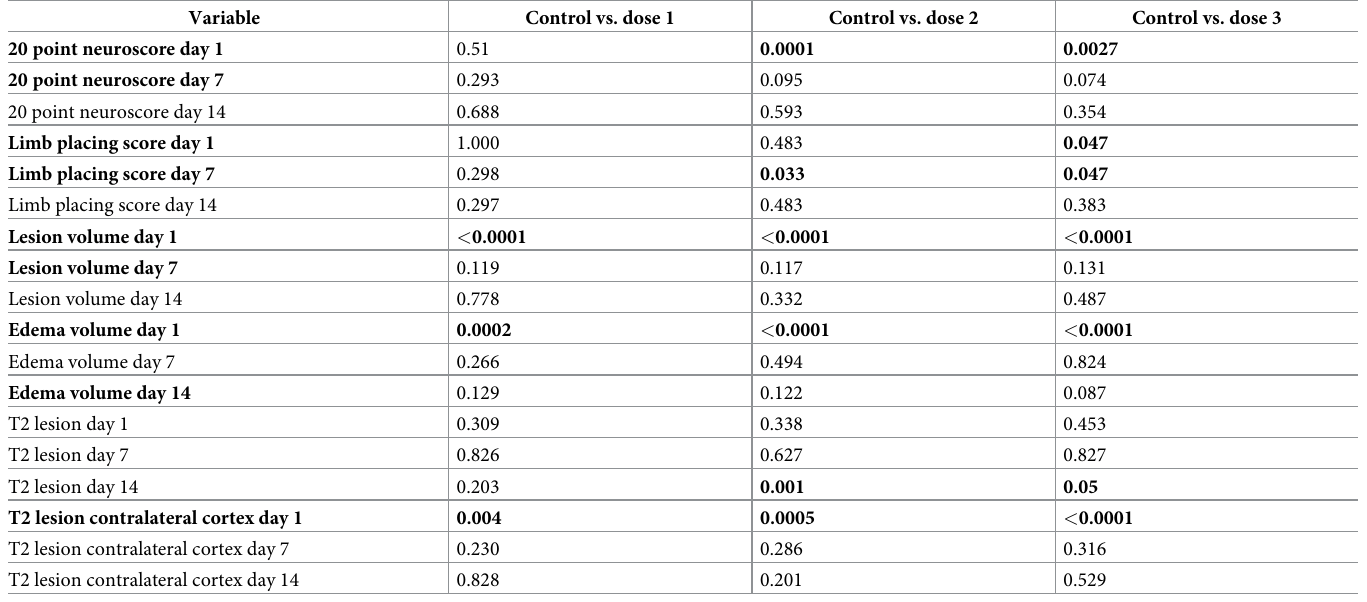
Table 1. Post-hoc analysis following linear mixed effects models for variables with repeated